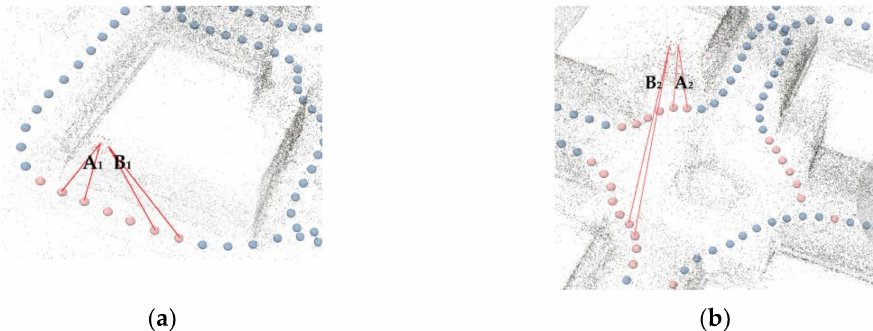
Figure 17. Triangulations between tie points and corresponding frames in the Pavilion. ( a ) A part near the top of the exterior walls; and ( b ) a part near the top of the interior walls. While their maximum intersection angles are similar (A 1 ≈ A 2 ), their minimums are very different (B1 >